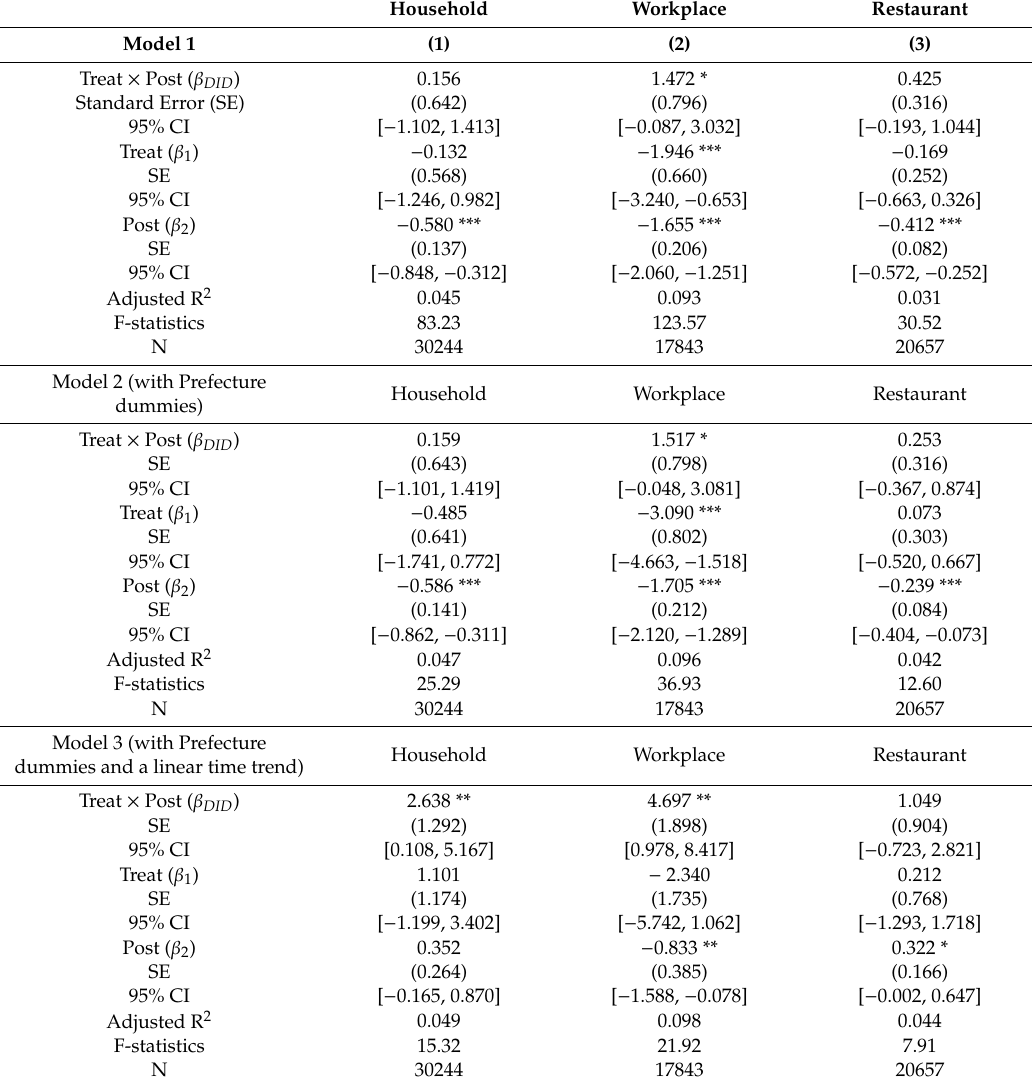
Table 2. The impact of a partial smoking ban on nonsmokers’ frequency of exposure to secondhand smoke (SHS) (measured by days of having exposure to SHS per